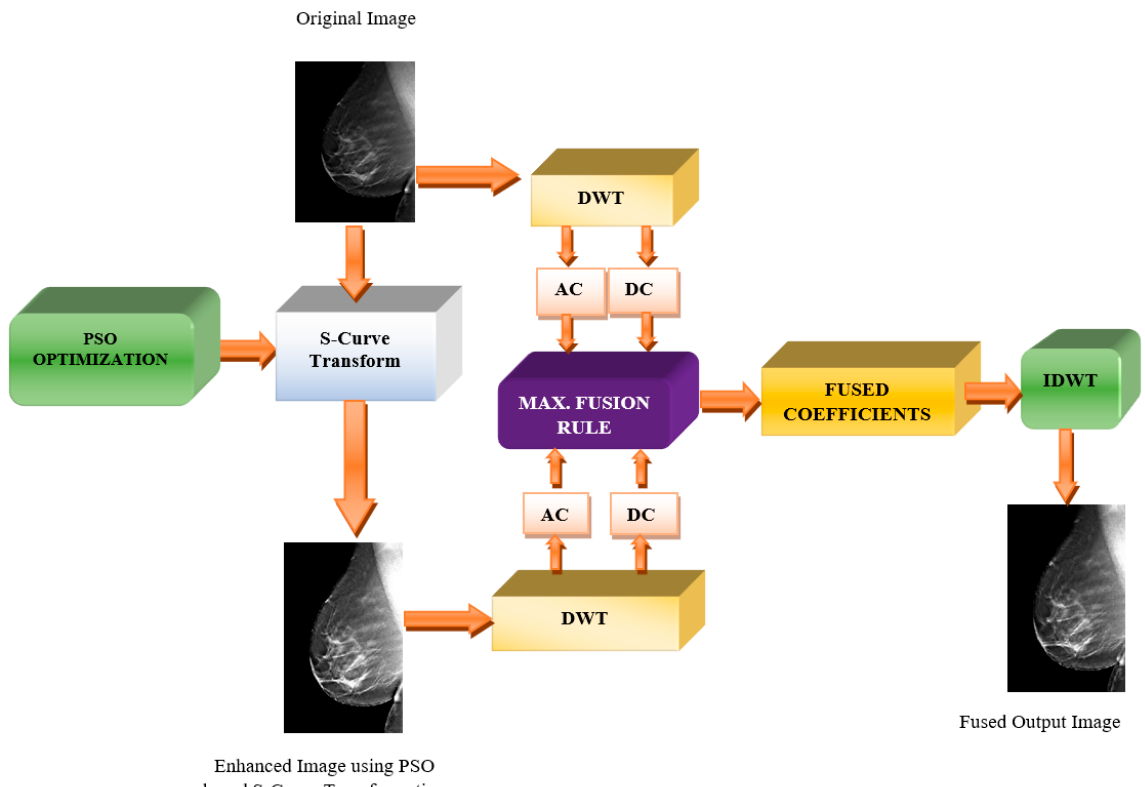
Figure 1. Block Diagram Showing Proposed Wavelet-based Medical Fusion Approach for Breast Images.